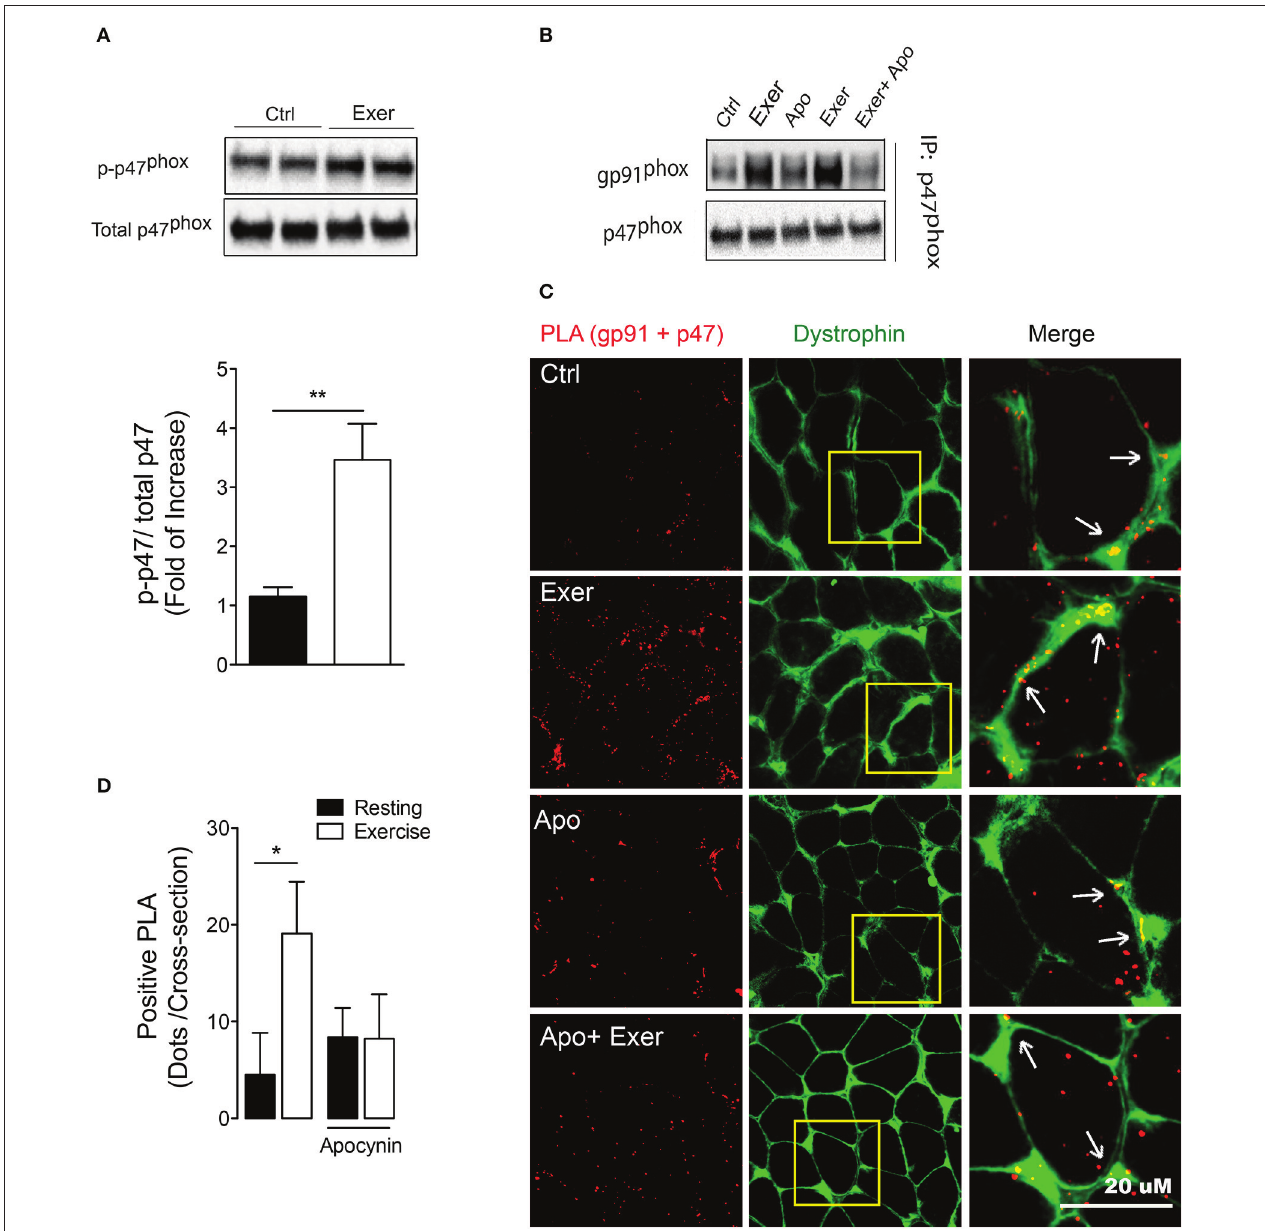
FIGURE 1 | Exercise-induced NOX2 activation was blocked by apocynin treatment. (A) Representative blot and quantitation of phospho-p47 phox levels in FDB muscle under rest and exercise conditions. (B) gp91 phox /p47 phox interaction by co-immunoprecipitation in muscle lysates in control conditions (Ctrl), after exercise (Exer), control with apocynin (Apo, NOX2 blocker) and exercise without and with apocynin. (C) Representative in situ proximity ligation assay (PLA) probes and (D) quantification for gp91 phox and p47 phox interaction as PLA dots after exercise in control and apocynin-treated mice. Anti-dystrophin antibody was used to define fiber perimeter. Arrows show colocalization of the PLA signal (red) with dystrophin (green). Data are expressed as mean ± SD from five different determinations. * p < 0.05 , ** p < 0.01 ; one-way ANOVA- Tukey and t - student were applied.